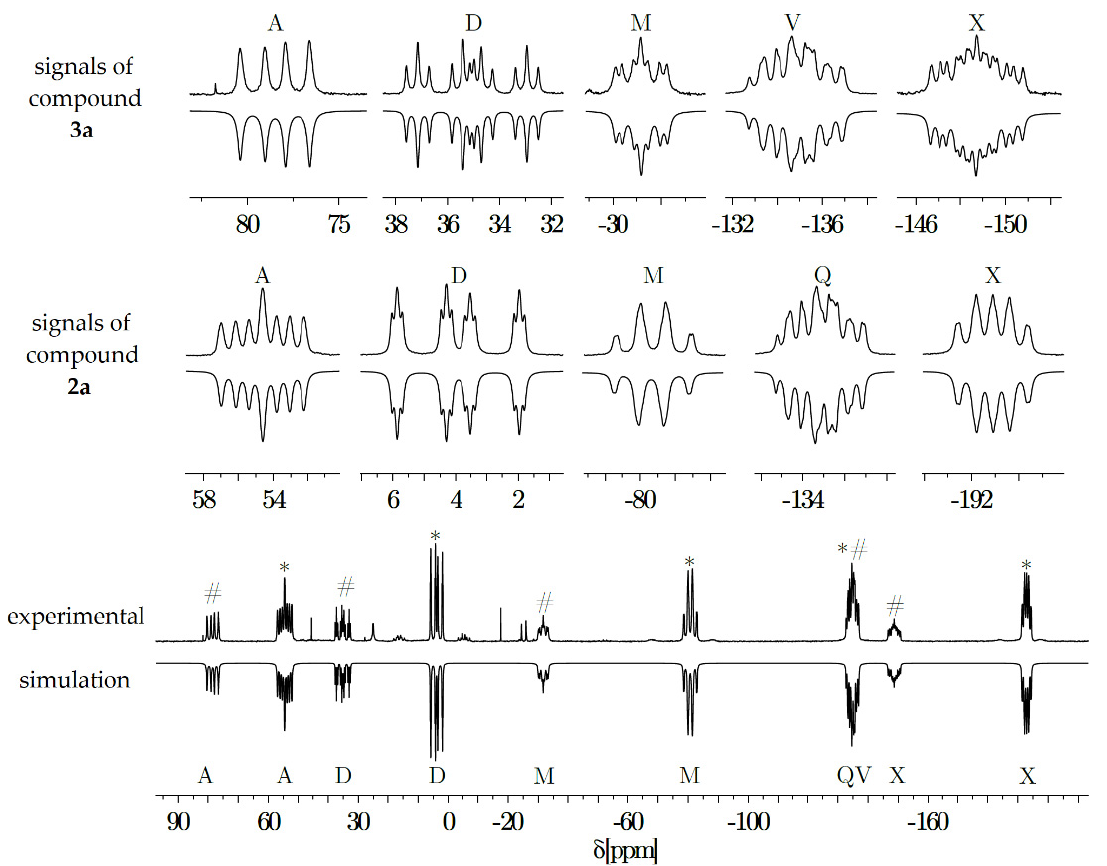
Figure 2. Experimental and simulated 31 P{ 1 H} NMR spectrum at 193 K of compounds 2a and 3a ( ∗ = 2a , # = 3a ). The multiplet Q/V is the result of two overlapping multiplets from the two different spin systems.